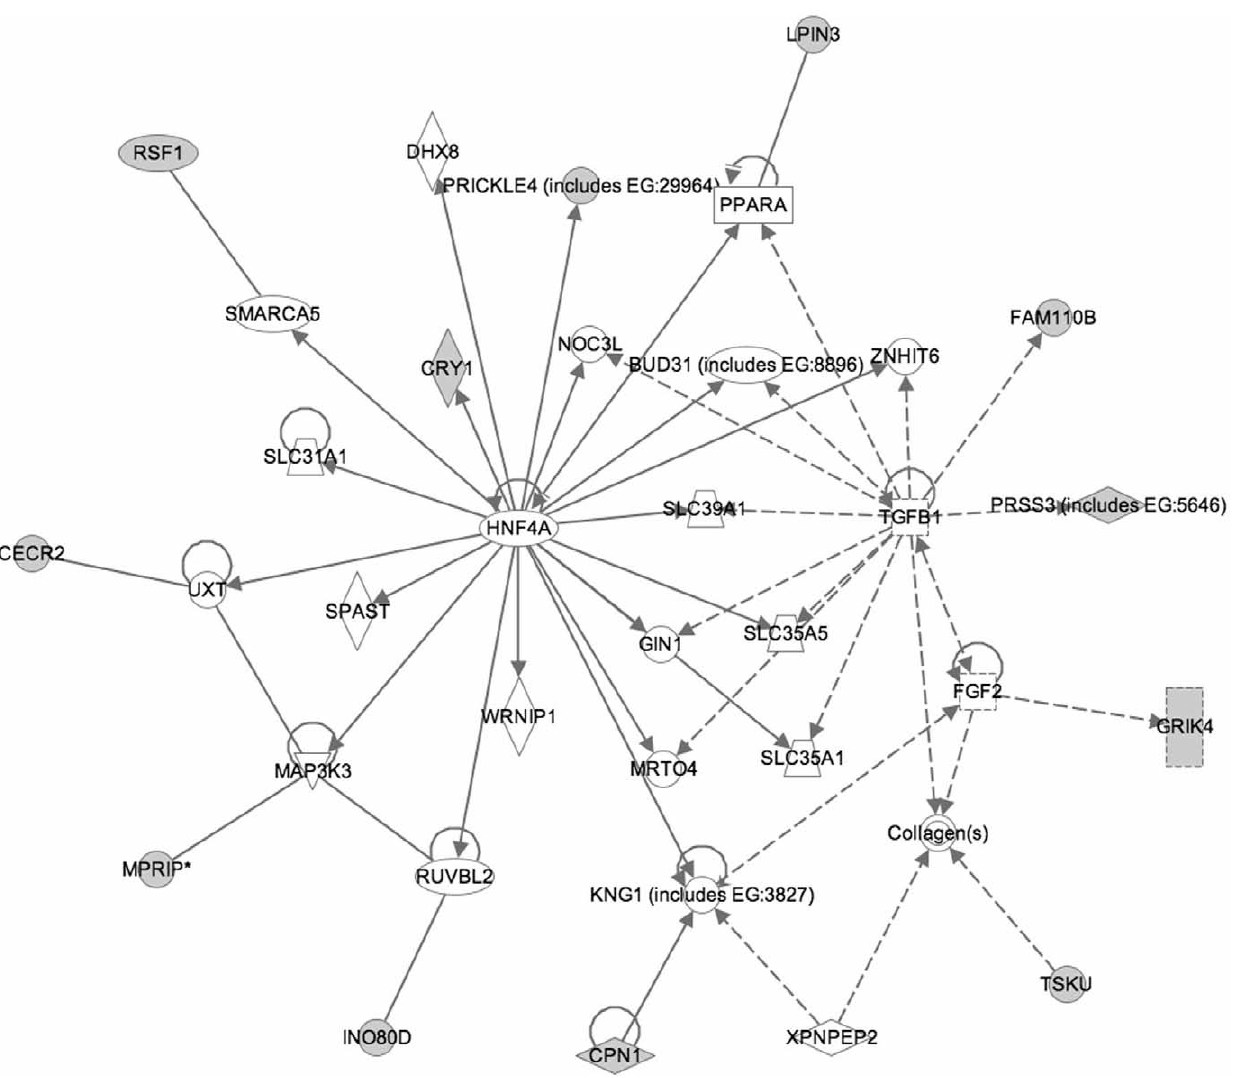
Figure 2. A second molecular interaction network suggested by Ingenuity Pathway Analysis (IPA), with HNF4A as a central node, consists of 12 genes among the top 56 differentially methylated loci. RefSeq IDs for 33 of the top 56 sites that mapped to genes were uploaded onto the ‘‘Core Analysis’’ tool of IPA. The second-highest scoring molecular interaction network was constructed by 35 nodes, 12 of which were located on the input list (shaded nodes), and is associated with the cell cycle, cellular function and maintenance, and connective tissue development and function. The nodal relationships are indicated by solid lines (direct interaction) and dashed lines (indirect interactions), with or without filled arrows indicating functional interaction or merely physical association, respectively. Additionally, filled arrows that are preceded by a terminal bar indicate inhibition as well as functional interaction. The shape of each node indicates the class of molecule: horizontal ovals are transcription factors, squares are growth factors, vertical rectangles are ion channels while horizontal rectangles are nuclear receptors, inverted triangles are kinases, vertical diamonds are enzymes while horizontal diamonds are peptidases, trapezoids are transporters, and circles correspond to ‘‘other’’ molecules. In alphabetical order, this network consists of BUD31, CECR1, Collagen(s), CPN1, CRY1, DHX8, FAM110B, FGF2, GIN1, GRIK4, HNF4A, INO80D, KNG1, LPIN3, MAP3K3, MPRIP, MRTO4, NOC3L, PPARA, PRICKLE4, PRSS3, RSF1, RUVBL2, SLC31A1, SLC35A1, SLC35A5, SLC39A1, SMARCA5, SPAST, TGFB1, TSKU, UXT, WRNIP1, XPNPEP2, and